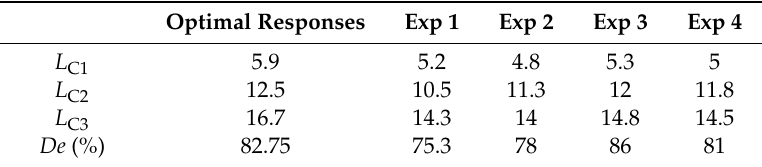
Table 5. Validation of the optimum